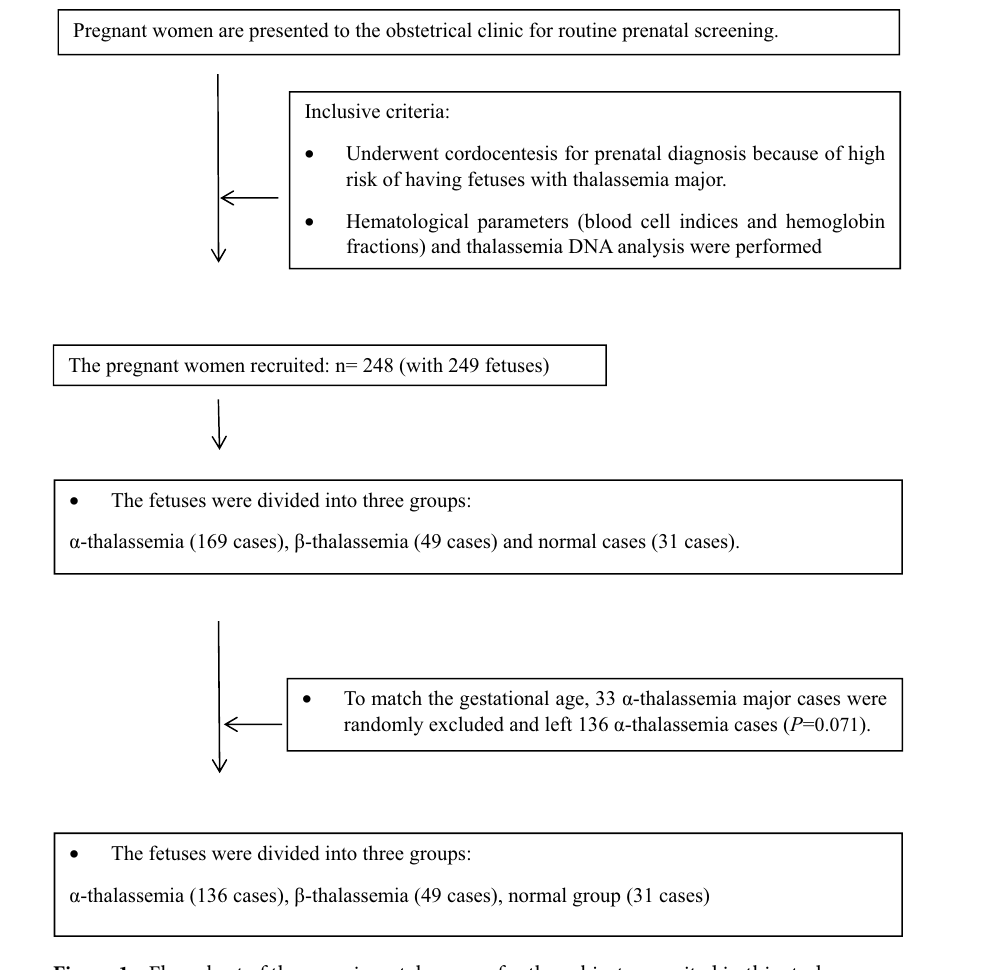
Figure 1. Flow chart of the experimental process for the subjects recruited in this